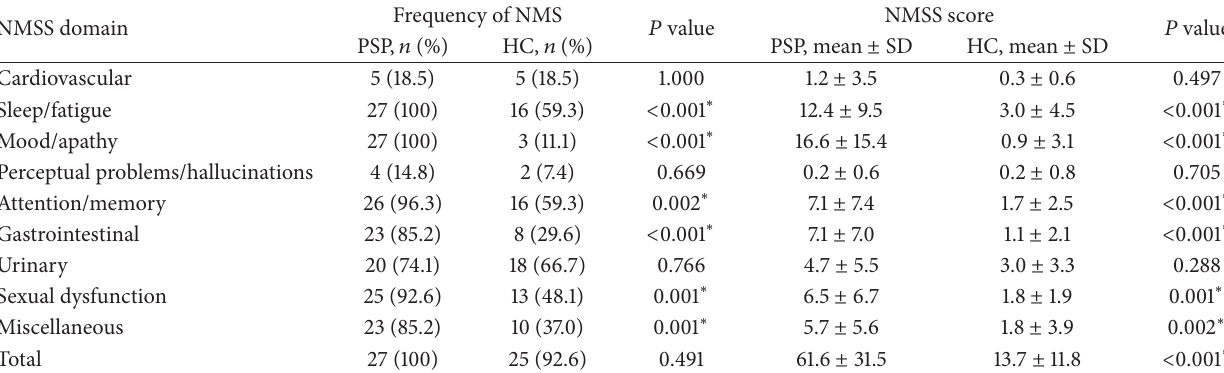
Table 2: Frequency of NMS and mean NMSS scores in PSP and HC.